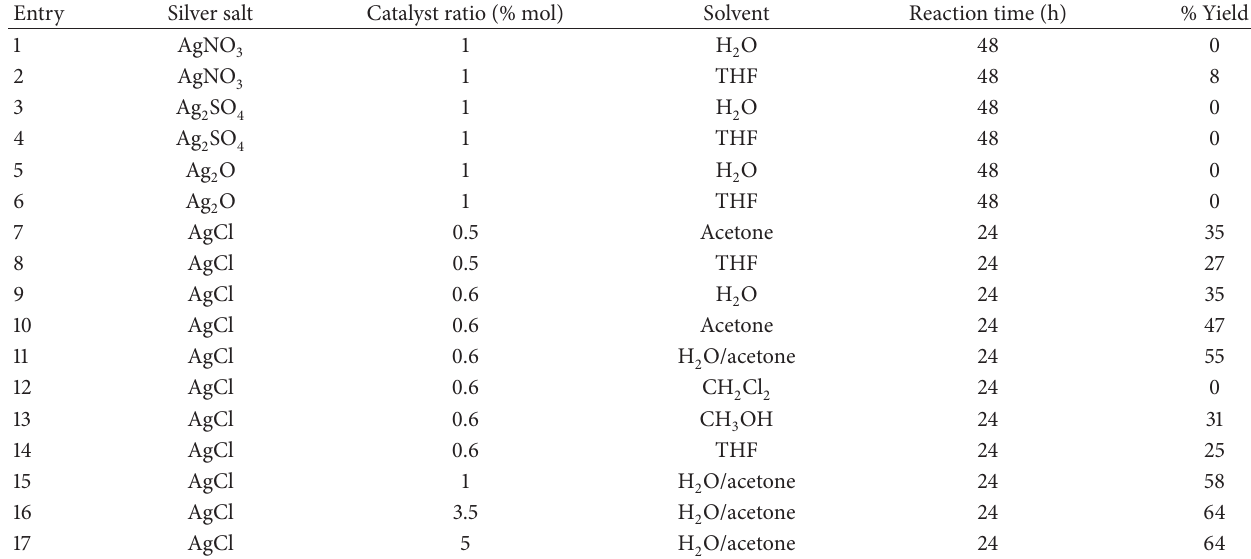
Table 1: Synthesis of triazole 3 catalyzed by silver salts.